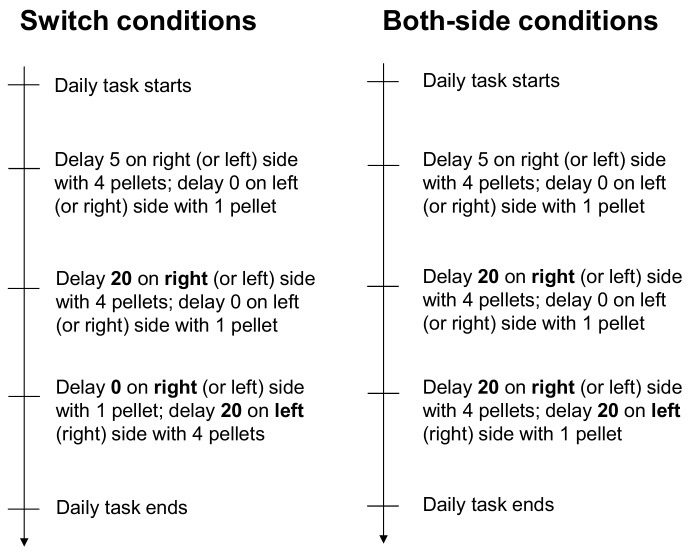
Daily timeline of the switch and both-side conditions.